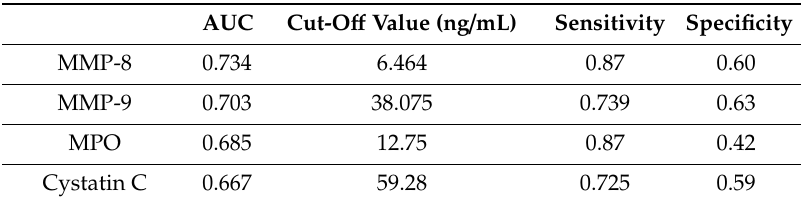
Table 3. Receiver operating characteristic (ROC) area under curve (AUC) of biomarkers and clinical parameters. Sensitivity and specificity of each biomarker were selected at the cut-o ff value points of the ROC curve.